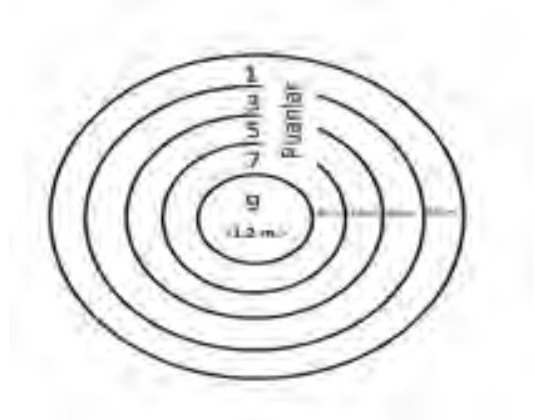
Figure 1. Dewitt-Dugan Board Measurements [12] Results